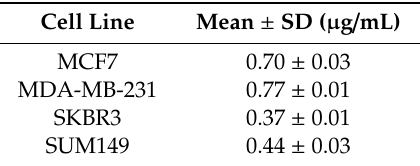
Table 1. Blyscan ™ assay of total sulfated Glycosaminoglycans (GAGs) in conditioned